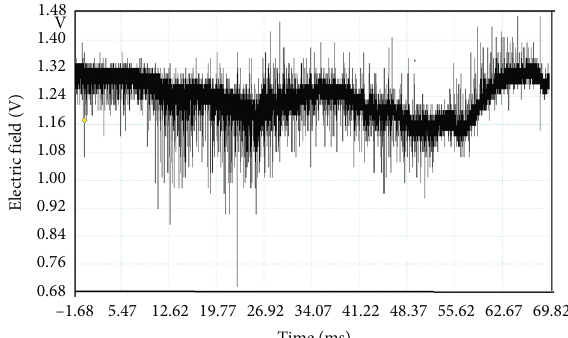
Figure 10: An expansion of the second stage of three-stage typical cloud flash of Figure 8.